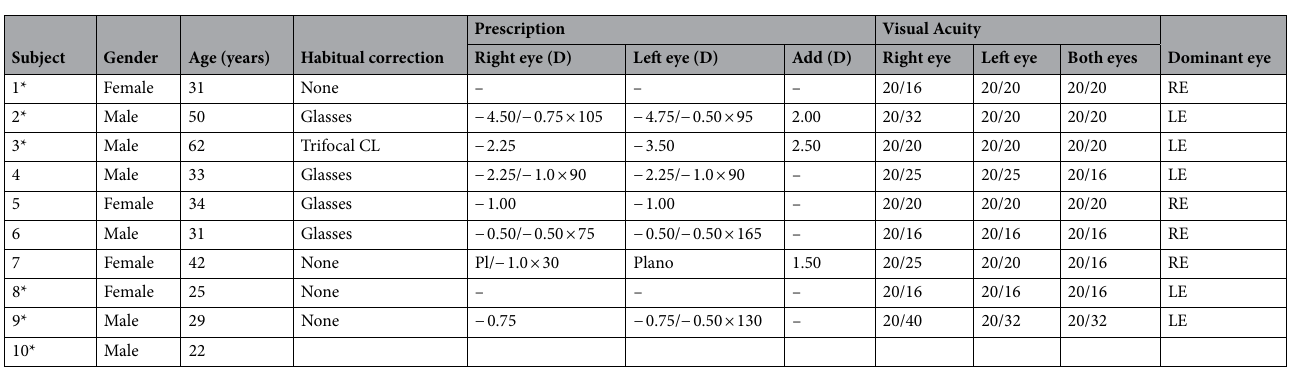
Table 1. Demographic data of ten subjects included in the study. Asterisk marks the subjects that performed the dichoptic viewing paradigms. We were unable to collect demographic data on subject 10 due to IRB stipulations associated with minimizing exposure to COVID-19. RE right eye, LE left eye.